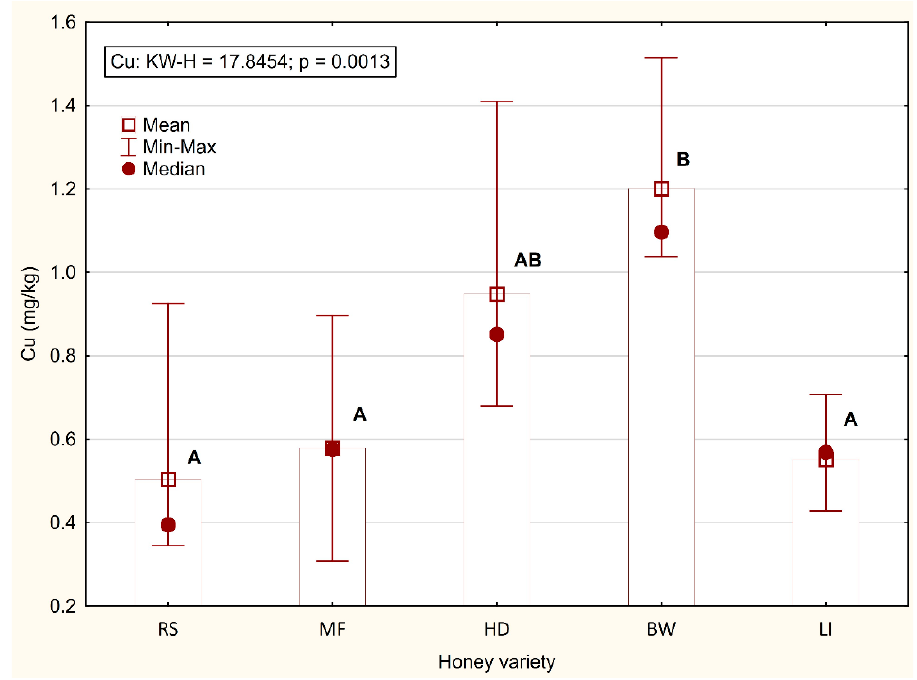
Figure 2. Content of Cu (mg/kg) in varietal honeys (RS–rapeseed; MF–multifloral; HD—honeydew; BW—buckwheat; LI—linden). Means with different letters (A, B) differ significantly ( p < 0.01).